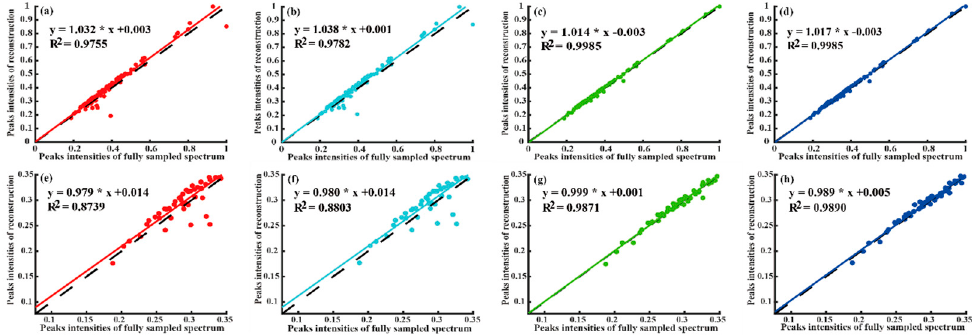
Figure 6. 1D traces of reconstructed 2D spectra ( a-1 )–( a-3 ) is the fully sampled spectrum of the 1D traces of HSQC spectra of GB1, the best-TROSY spectrum of ubiquitin, and solid NMR spectrum, respectively. ( b-1 )–( b-3 ), ( c-1 )–( c-3 ), ( d-1 )–( d-3 ), and ( e-1 )–( e-3 ) are reconstructed spectra using LRHM, LRHMF, SLS, and SLSMF, respectively. Note: ( a-1 )–( a-3 ) are fully sampled spectra of 1D traces, and their locations in the corresponding fully sampled spectrum are marked with a dotted line in Figures 3–5.